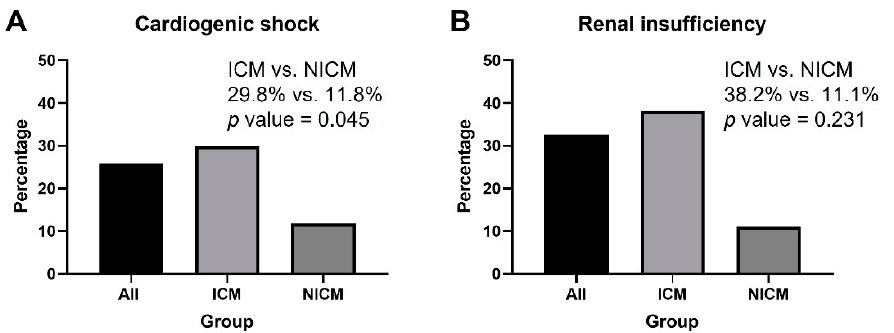
Figure 3. The 30 day all-cause mortality rate in the subgroups with cardiogenic shock and renal insufficiency (eGFR < 30 mL/min/1.73 m 2 ): ( A ) significantly higher incidence of 30 day all-cause mortality presented in the ICM group was noted in the patients with cardiogenic shock; ( B ) the incidence of 30 day all-cause mortality did not differ between two groups in the patients with eGFR < 30 mL/min/1.73 m 2 . ICM: ischemic cardiomyopathy; NICM: non-ischemic cardiomyopathy; eGFR: estimated Glomerular filtration rate.